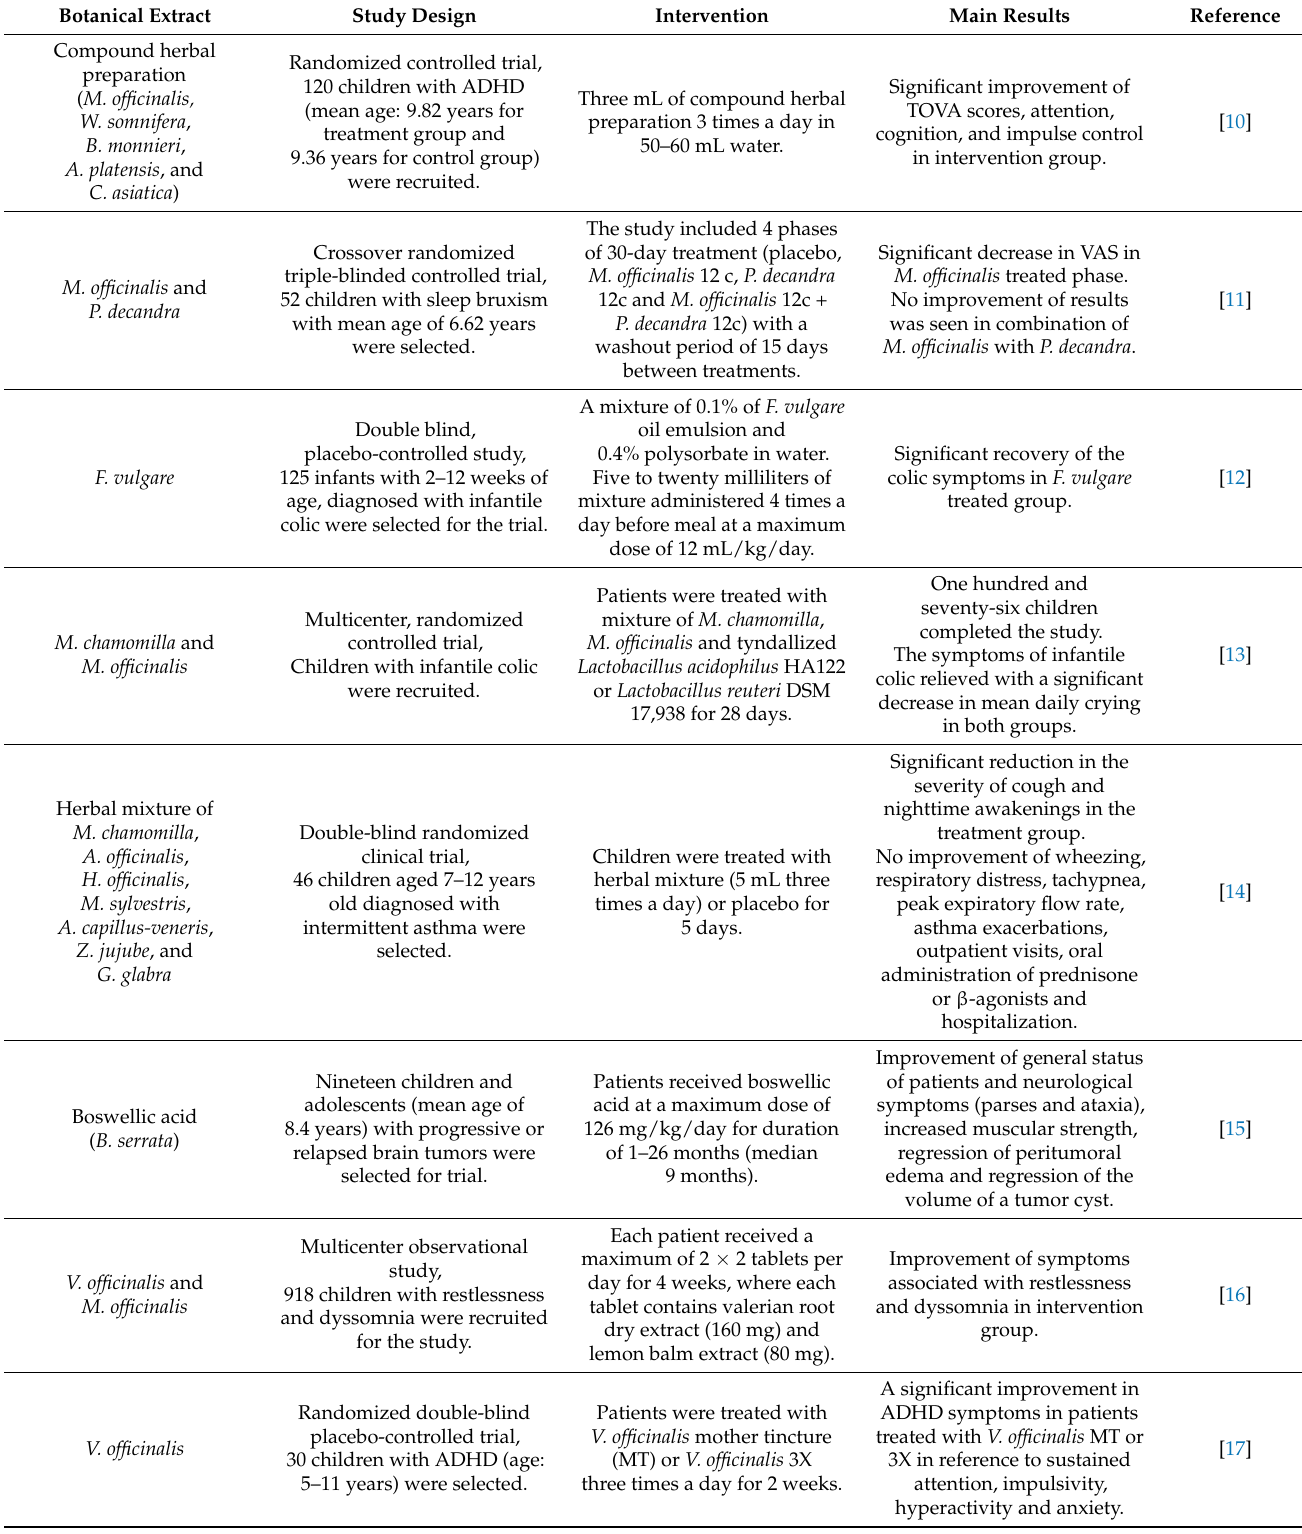
Table 1. Evidence of botanical extract supplementation in children from clinical